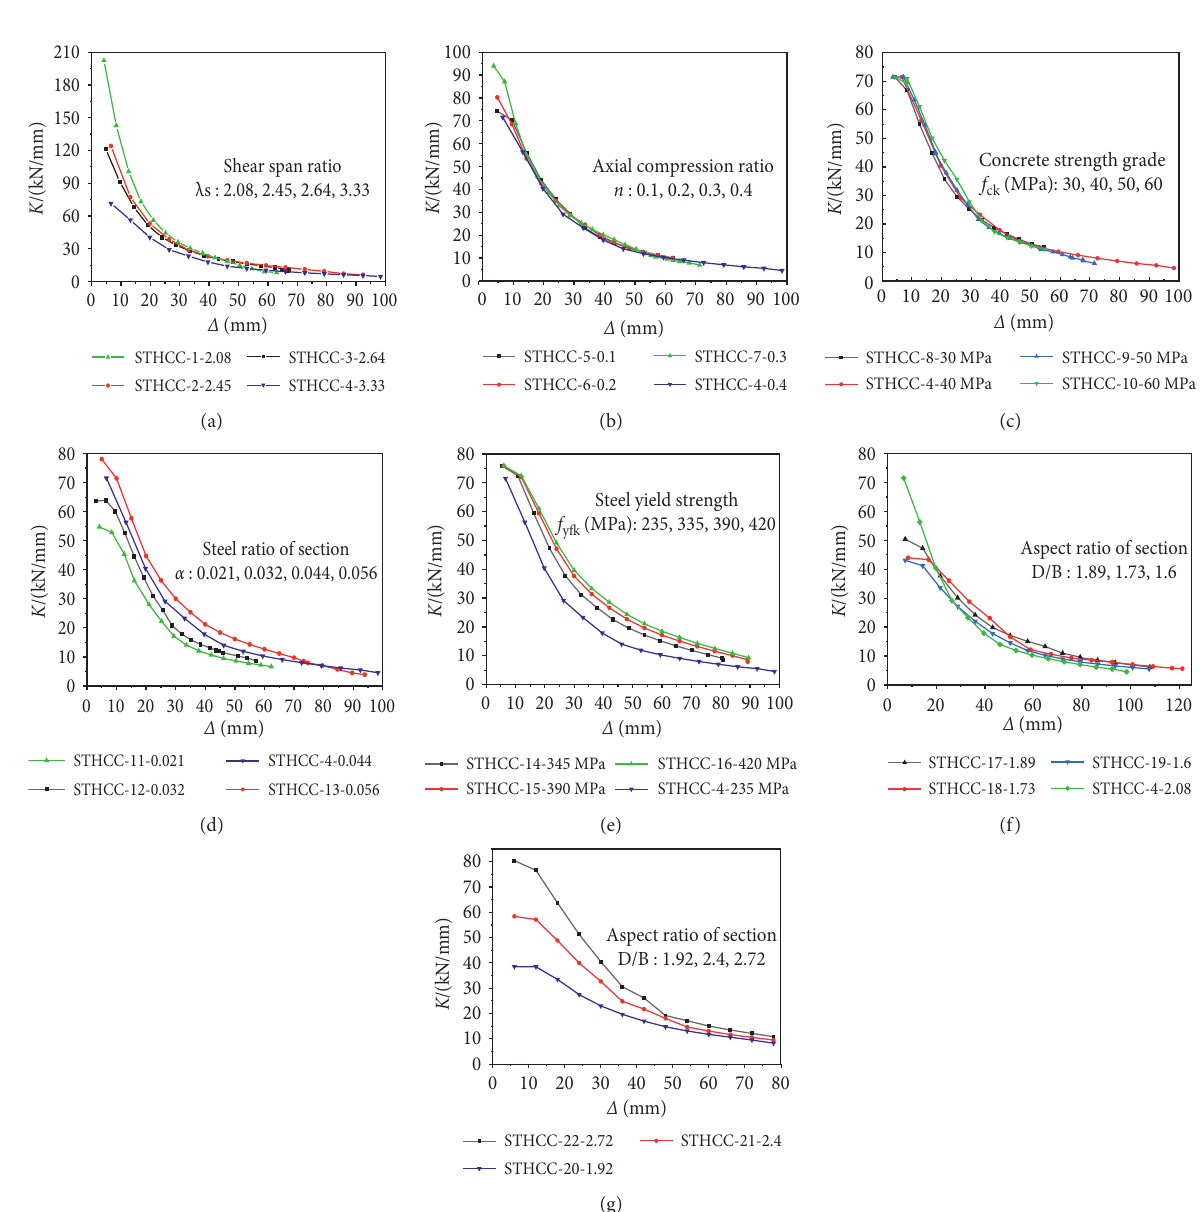
Figure 12: The relationships between K i and Δ for STHCCs with different parameters. (a) λ s : 2.08, 2.45, 2.64, 3.33. (b) f ck : 30MPa, 40MPa, 50MPa, 60MPa. (c) n : 0.1, 0.2, 0.3, 0.4. (d) α : 0.021, 0.032, 0.044, 0.056. (e) f yfk : 235MPa, 335MPa, 390MPa, 420MPa. (f) D / B :1.89, 1.73, 1.6. (g) D / B : 1.92, 2.4, 2.72.